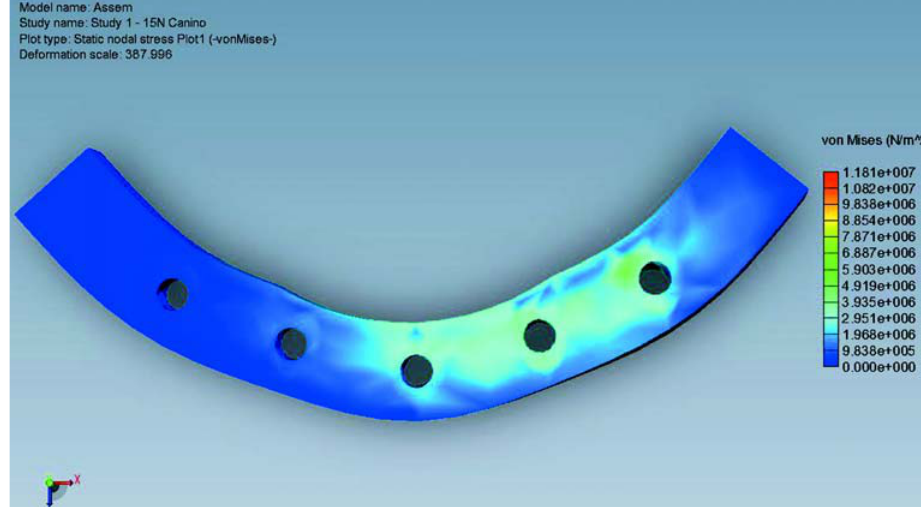
FIGURE 2- Disocclusion in canine guide, anterior view